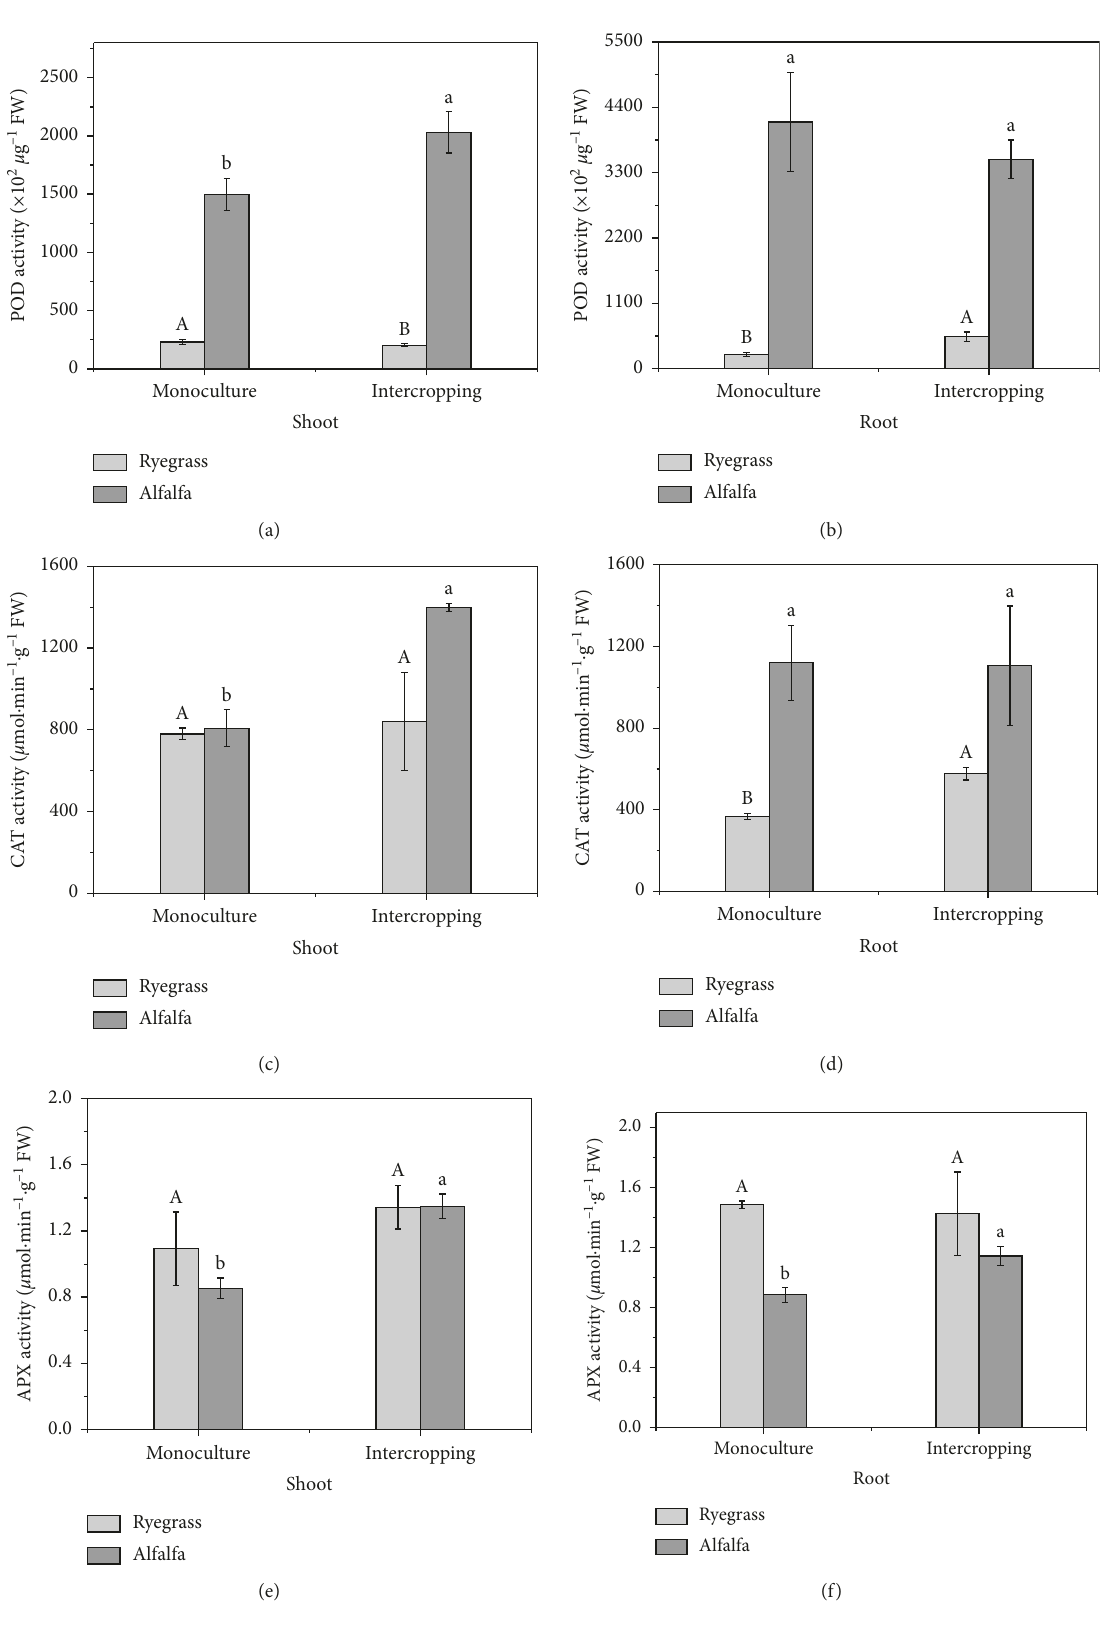
Figure 5: The antioxidant enzyme system contents in shoots and roots of ryegrass and alfalfa under the monoculture and intercropping treatments. POD activity in shoots (a), POD activity in roots (b), CATactivity in shoots (c), CATactivity in roots (d), APX activity in shoots (e), and APX activity in roots (f). Bars are standard error ( n � 3). Means followed by the same letter are not significantly different at p < 0 . 05 of ryegrass and alfalfa with different